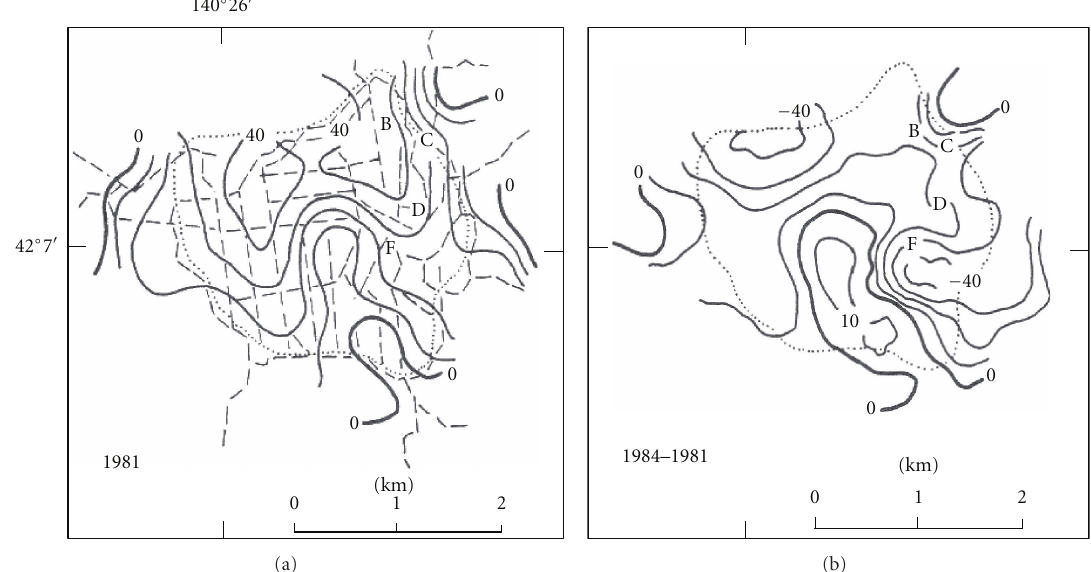
Figure 9: Self-potential distributions in the Nigorikawa caldera (a) measured in 1981 and (b) di ff erence in SP distribution between 1981 and 1984, after [145]. Contour interval is 10mV. Broken lines shown in (a) denote survey lines used for 1981 and 1984 surveys (the data sampling intervals are 100 m). The edge of the caldera floor is indicated by the dotted lines. B, C, D, and F represent well sites.